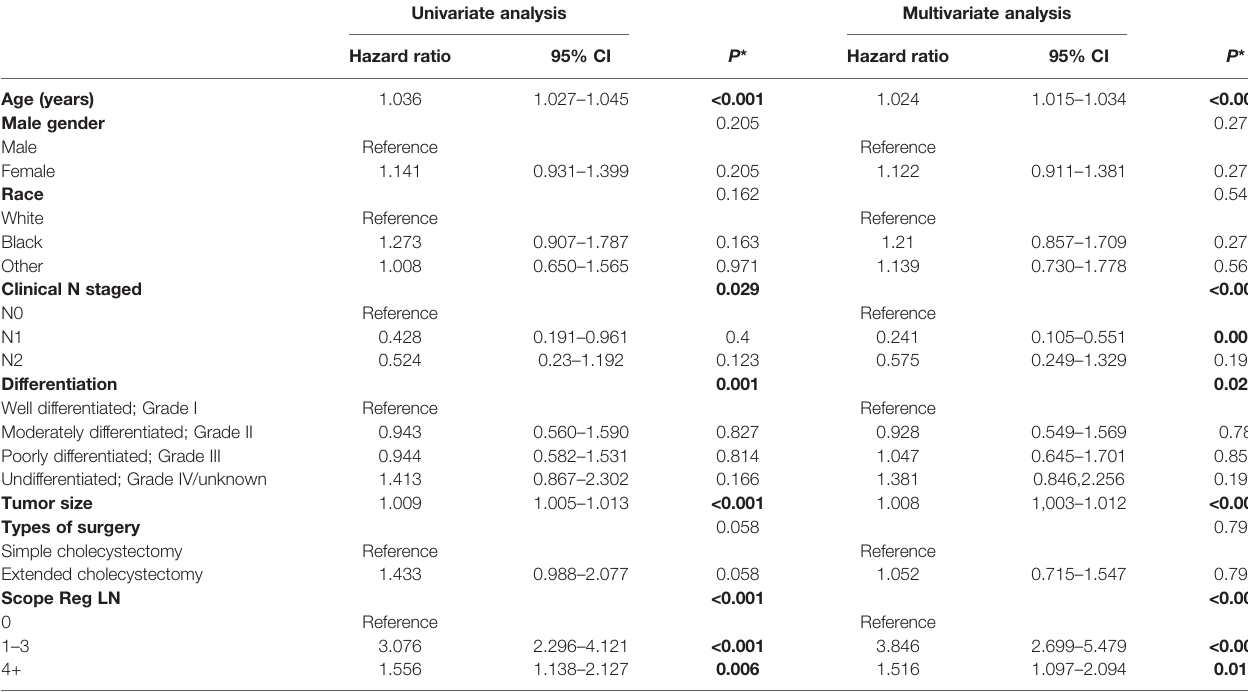
TABLE 3 | Univariate and multivariate Cox hazard analysis of risk factors for overall survival